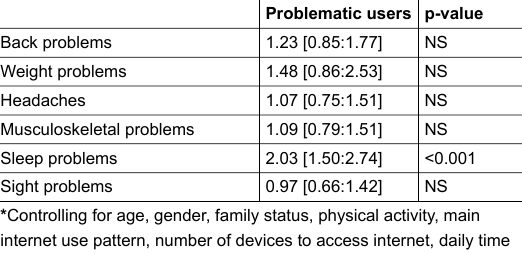
Table 3: Multivariate analysis including all the health problems at the same time using average users as the reference group